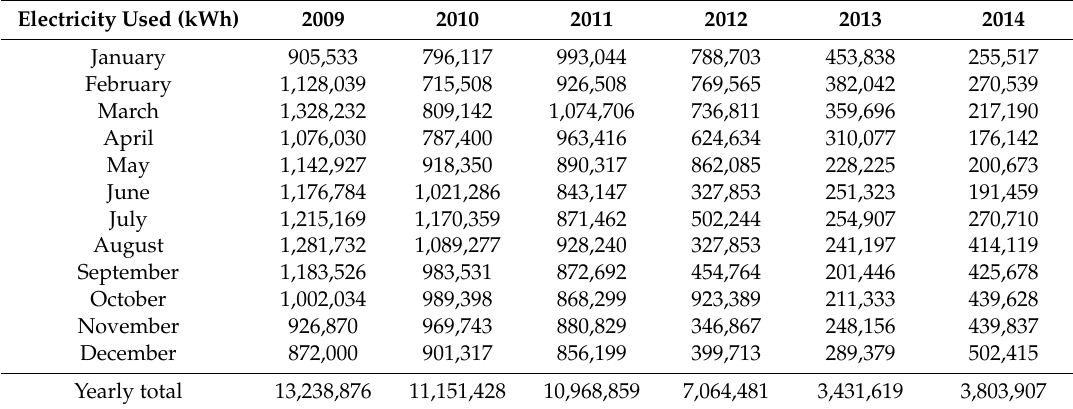
Table 2. Past data for electricity usage of the manufacturing plant. These data are used to predict future